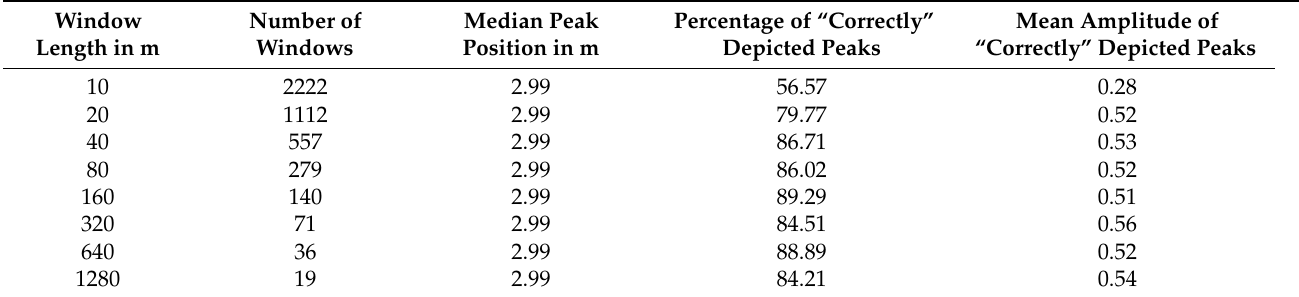
Table 2. Results of segmented cepstrum analysis with different window sizes.